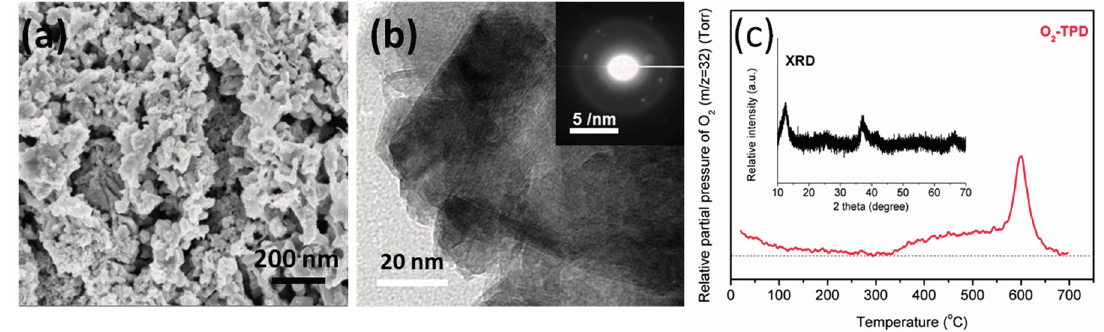
Figure 13. (a) SEM images; ( b ) HRTEM, (in set, selected area diffraction (SAD)); ( c ) O 2 -temperature programmed desorption (inset, XRD pattern) of